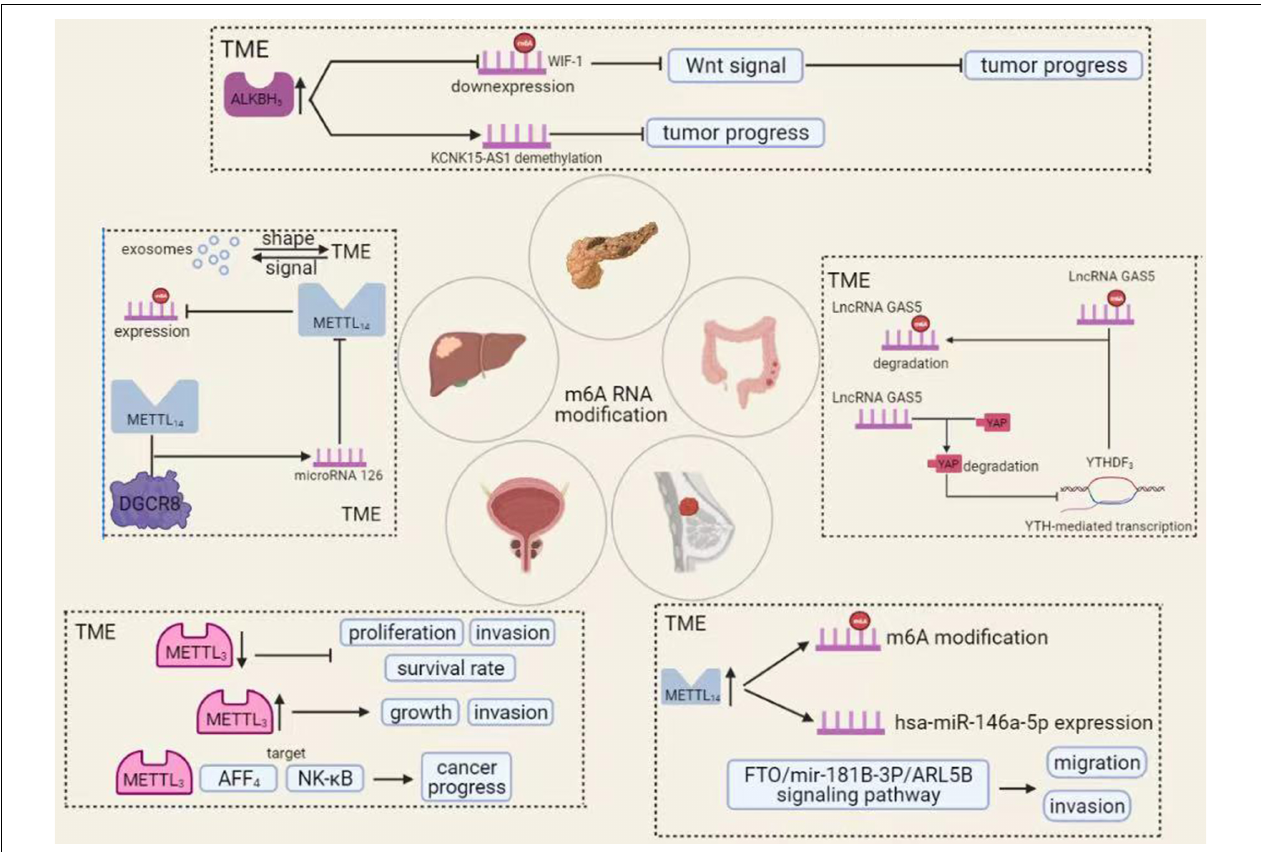
FIGURE 5 | The roles of m6A RNA modification in TME of various cancers. A variety of chemical modifications occur within the tumor microenvironment that is important for tumorigenesis and progression. Among these, m6A RNA modification is the most abundant. In different tumors, m6A RNA modifications can affect cancer progression in various